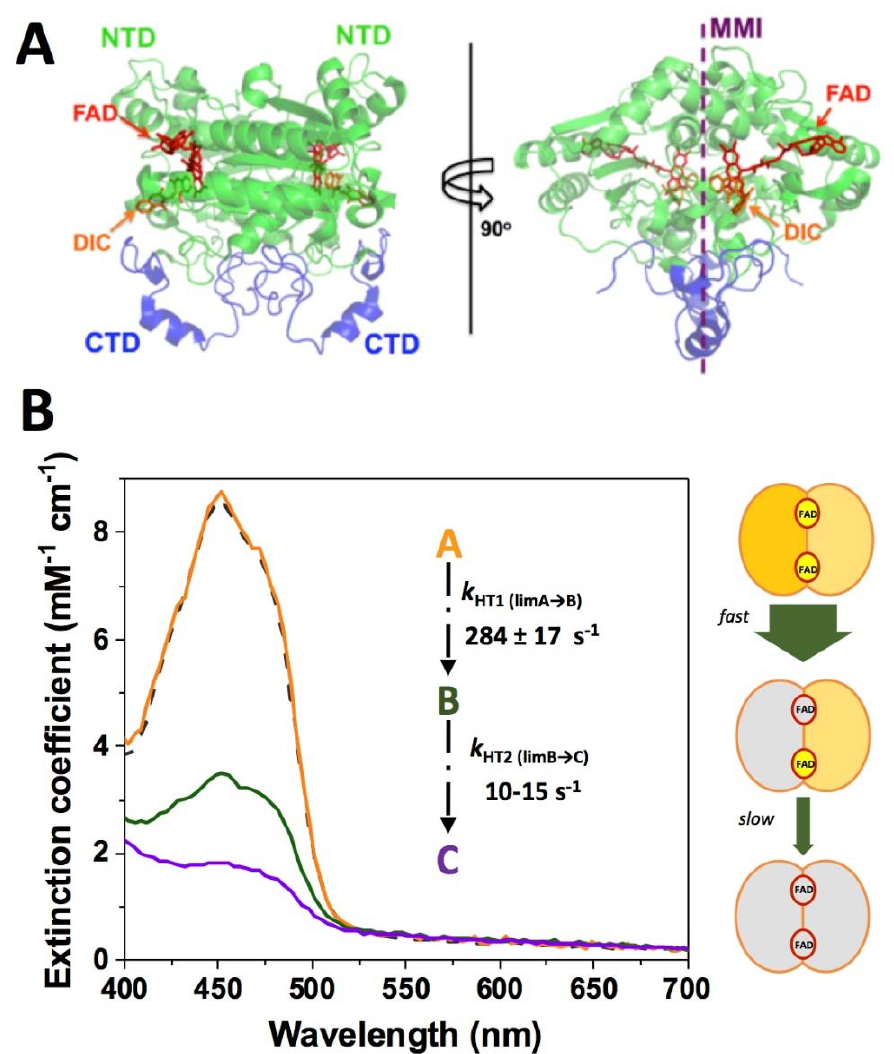
Figure 3. Structure and catalytic function of NQO1. ( A ) Structural representation of the NQO1 dimer (PDB 2F1O) [83]. NTD and CTD refer to N-terminal and C-terminal domains, respectively. The location of the FAD and the inhibitor dicoumarol (DIC) binding sites is also indicated. The monomer:monomer interface is indicated as MMI. ( B ) Reduction of FAD by NADH shows two different pathways. In the left panel, the spectral properties of the different spectroscopic species (A, B, C) stabilized upon reduction are indicated as well as their conversion limiting rate constants. The right panel shows the model proposed by us for the sequential reduction of the two FAD cofactors in the protein homo-dimer, in which this large difference in kinetics represents a type of functional negative cooperativity. Adapted from